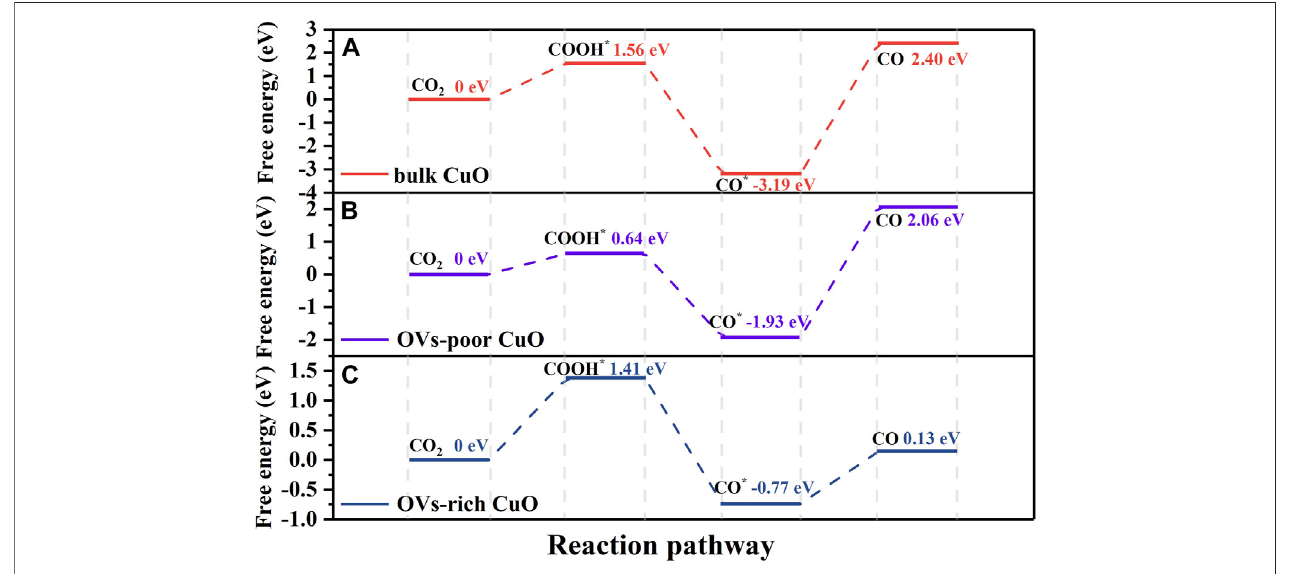
FIGURE 9 | Reaction free energy diagram toward various intermediates on the (111) facet of (A) bulk CuO, (B) OVs-poor CuO, and (C) OVs-rich CuO.